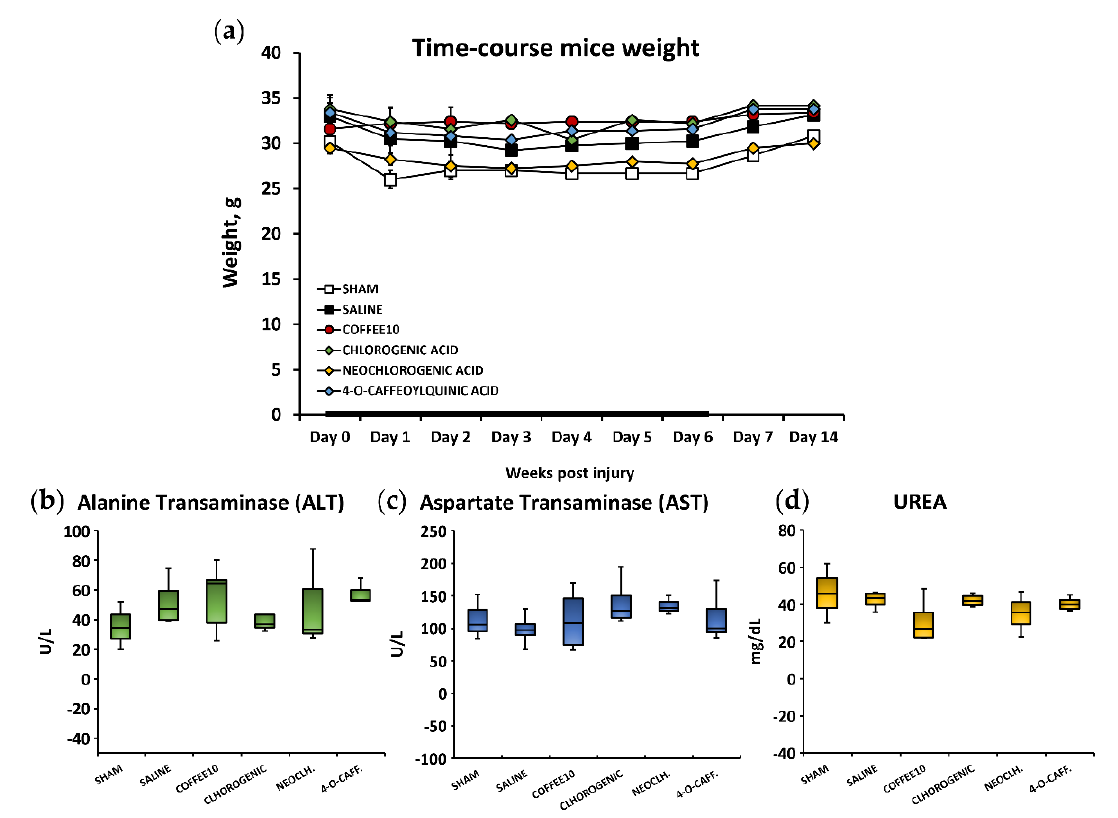
Figure 7. ( a ) Time − course weight. Data are illustrated as mean ± SEM. Administration week (W0 to W1) is highlighted with a thicker line. No differences between groups are shown over time. Serum biomarkers quantification of ( b , c ) hepatotoxicity and ( d ) nephrotoxicity of each experimental group fourteen days post-injury. Data are illustrated as median ± IQR, and the x indicate the mean. No differences between groups are shown in any of the parameters.